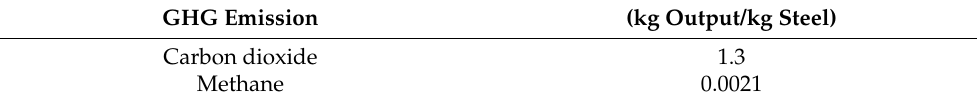
The emissions of the life cycle inventory (LCI) are presented in Table 5. The contribu- tion of the listed emissions to climate change is at least 99%. Table 5. GHG emissions of steel production using natural gas-based DR plant and EAF.